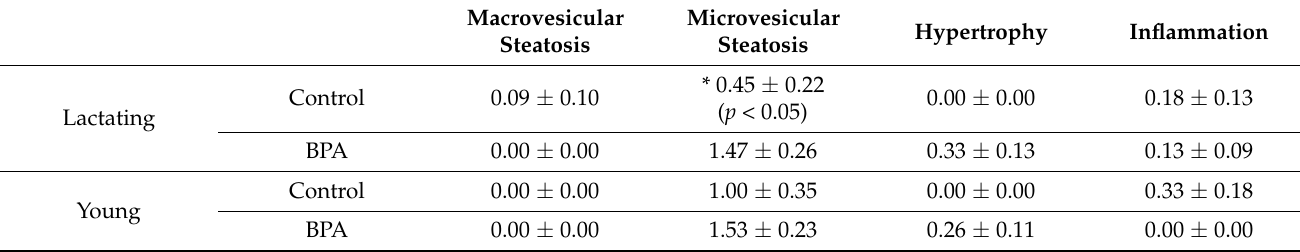
Data are expressed as mean ± SE. * Statistically significant difference vs. control